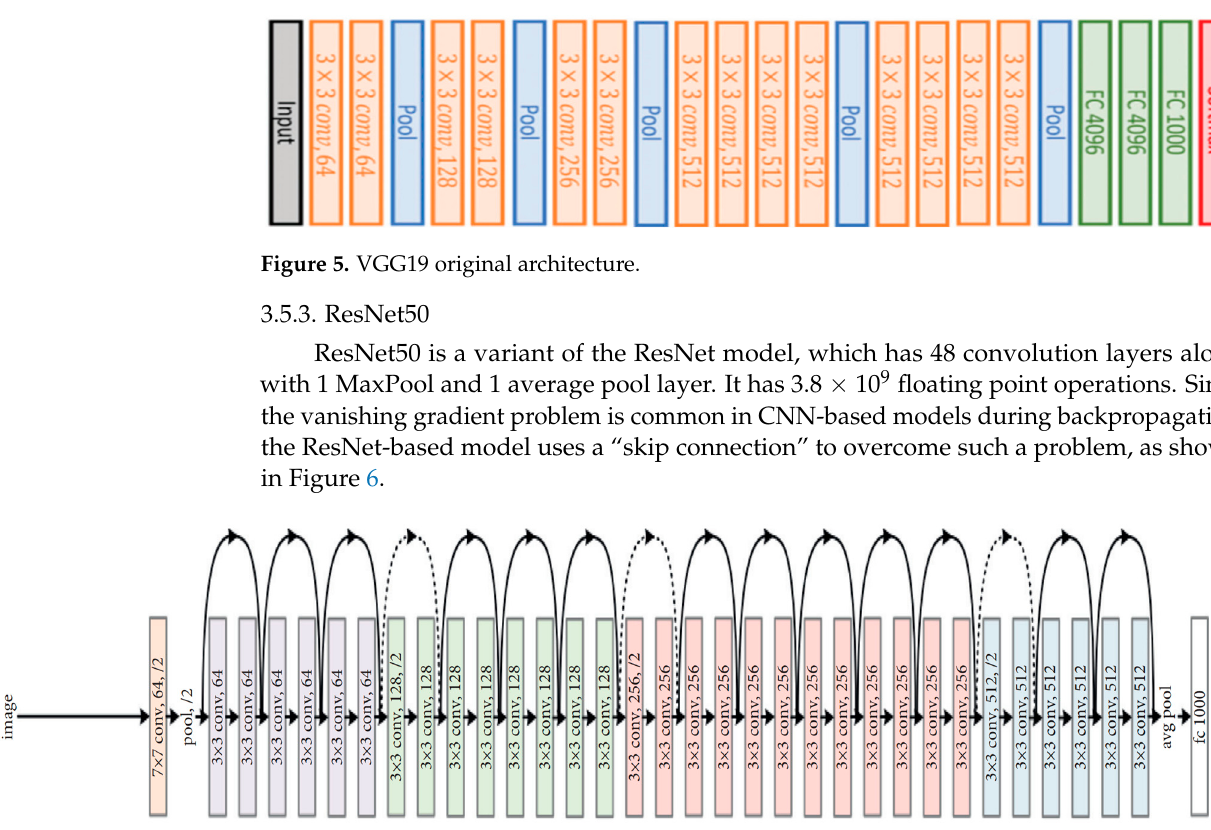
Figure 6. Architecture of the ResNet50 model, the black curved arrows show “skip connection” among the layers.